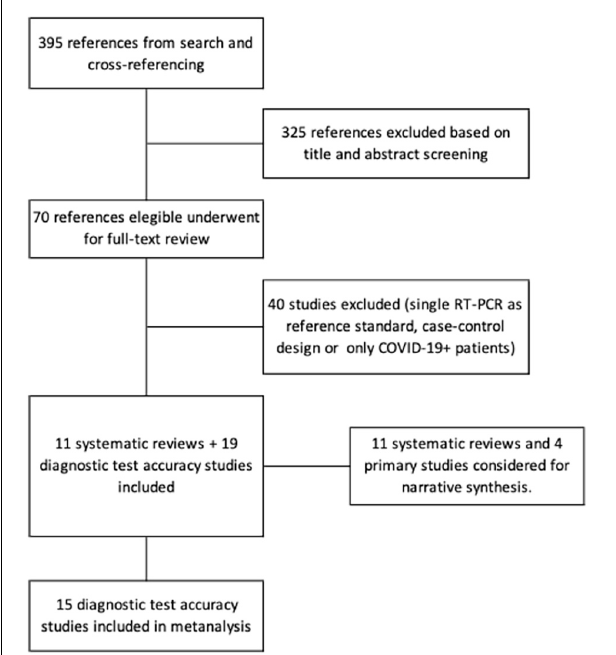
FIGURE 1 | PRISMA flow diagram of the studies selection